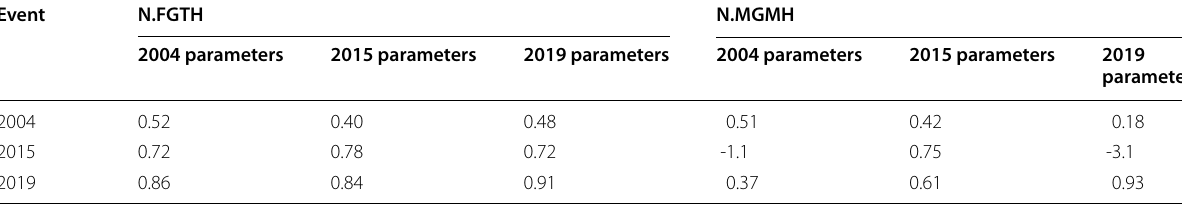
Table 2 NSE values evaluated for each heavy rain event using parameters estimated for all heavy rain events Event N.FGTH